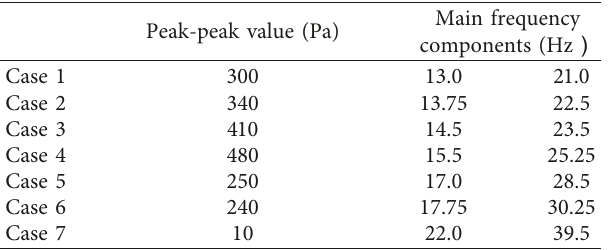
Table 2: Peak-peak value and main frequency components of seven cases.